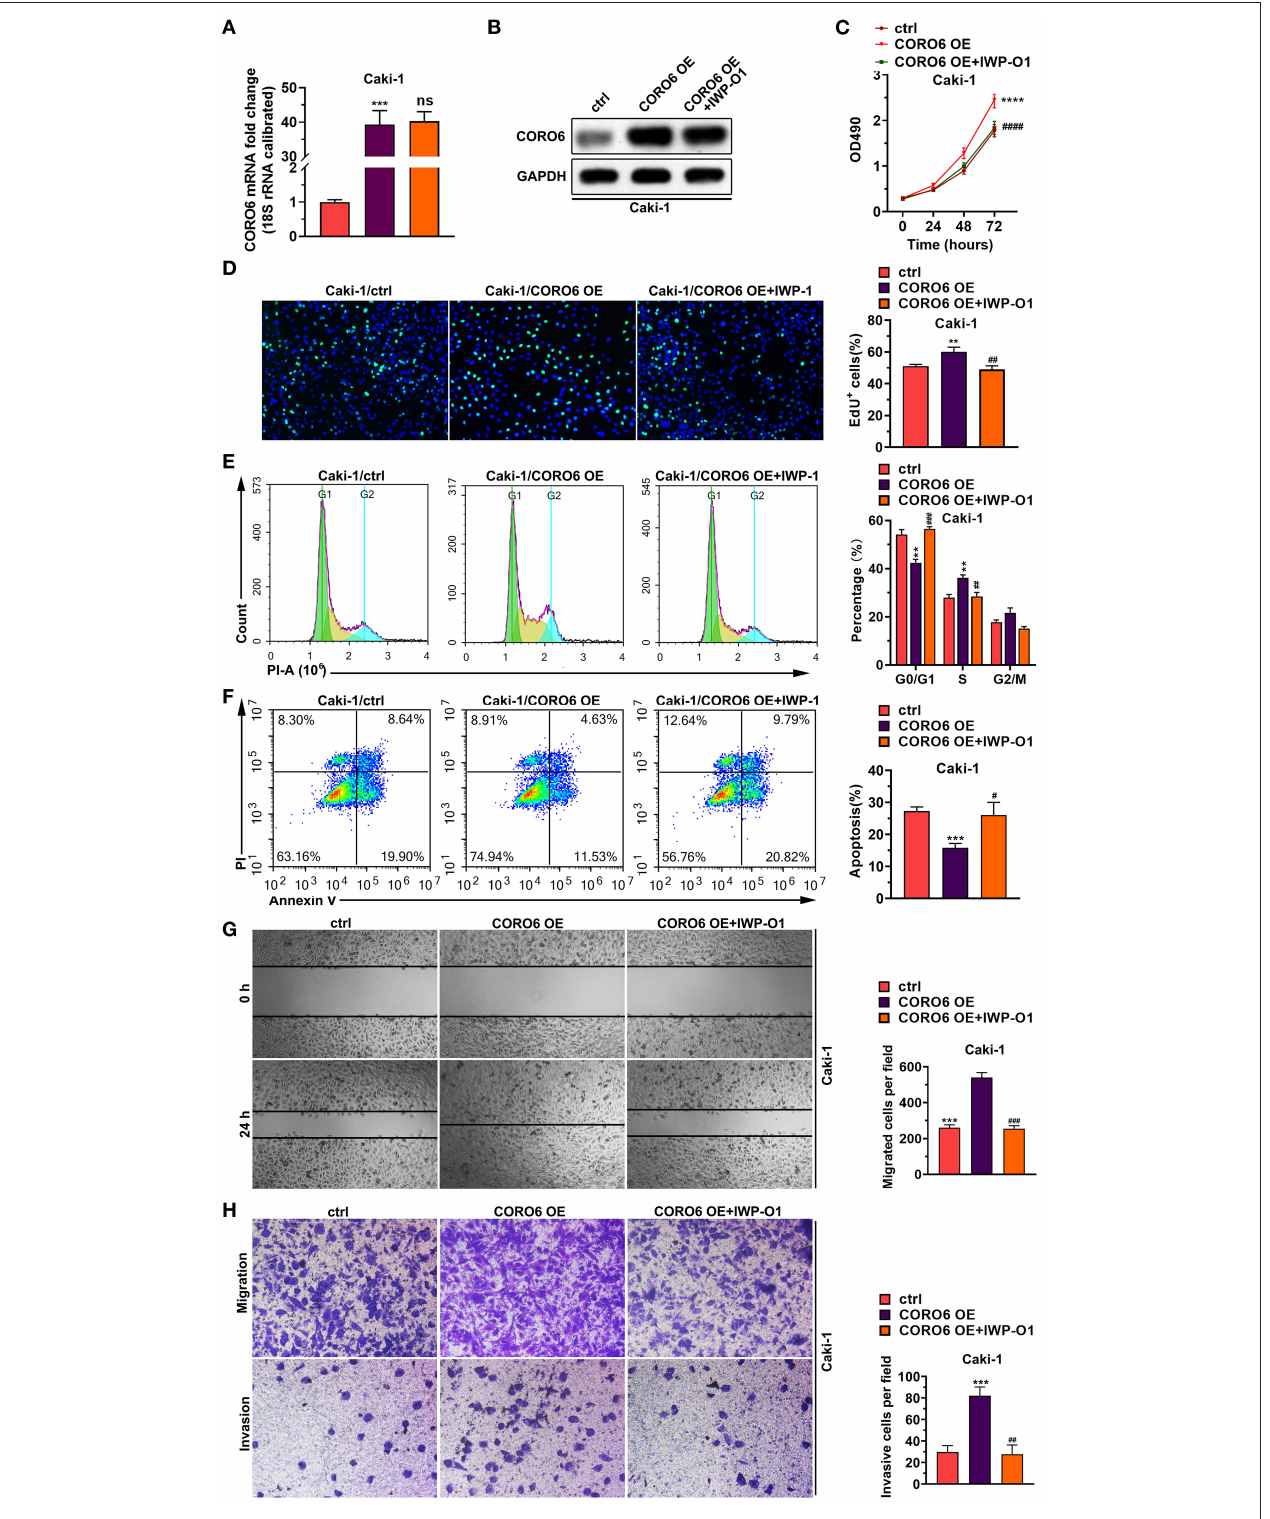
FIGURE 8 | CORO6-induced ccRCC cell growth and cell invasion/migration were dependent on WNT activation. (A) IWP-O1 had no effect on the CORO6 mRNA level. 18s rRNA was used as the normalizing control. (B) IWP-O1 had no effect on the CORO6 protein level. GAPDH served as the loading control. (C) The MTT assay